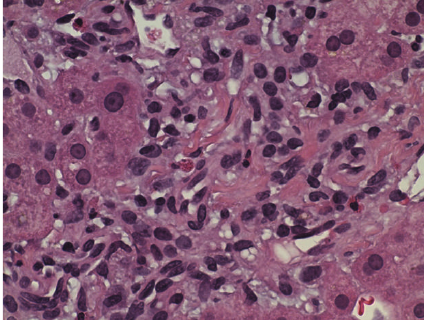
Figure 2: Portal tract with few eosinophils.